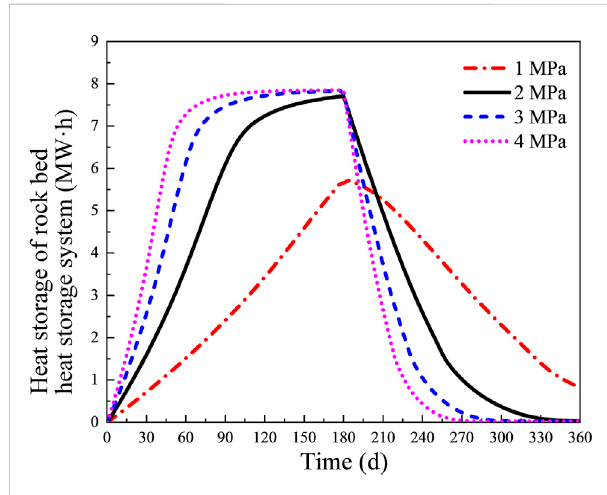
FIGURE 8 The change of rock bed heat storage with time under different CO2 injection pressures.